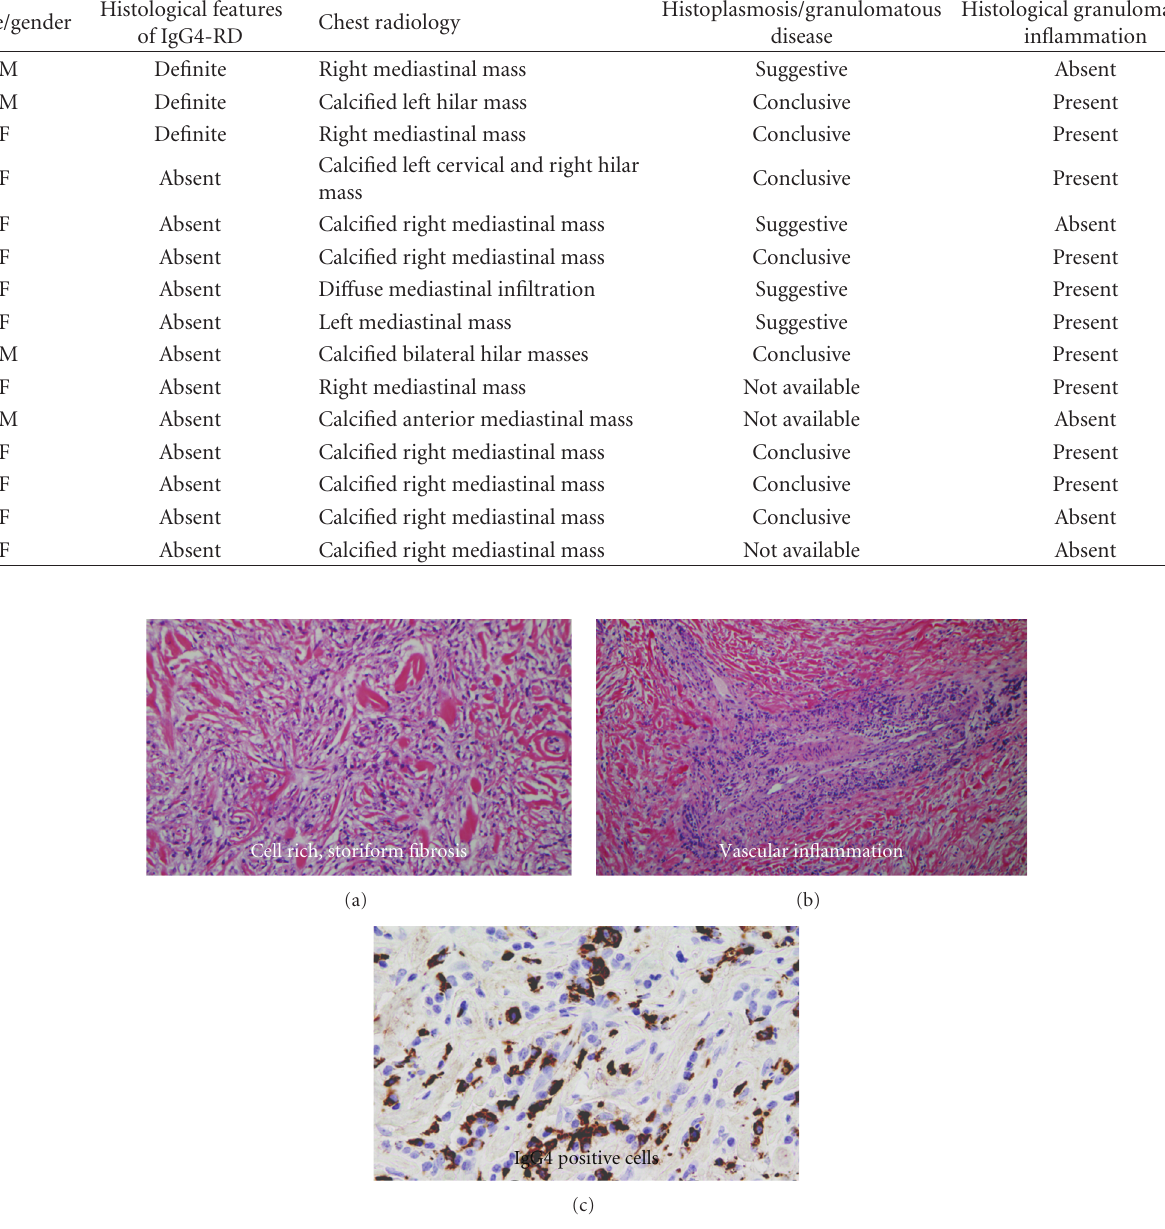
Figure 1: Histopathological changes and IgG4 immunostaining demonstrate an overlap between FM and IgG4-RD in a subset of patients ( n = 3), (a). cell rich, storiform fibrosis, (b). vascular inflammation and (c). IgG4 positive plasma cells. (representative images selected from 3